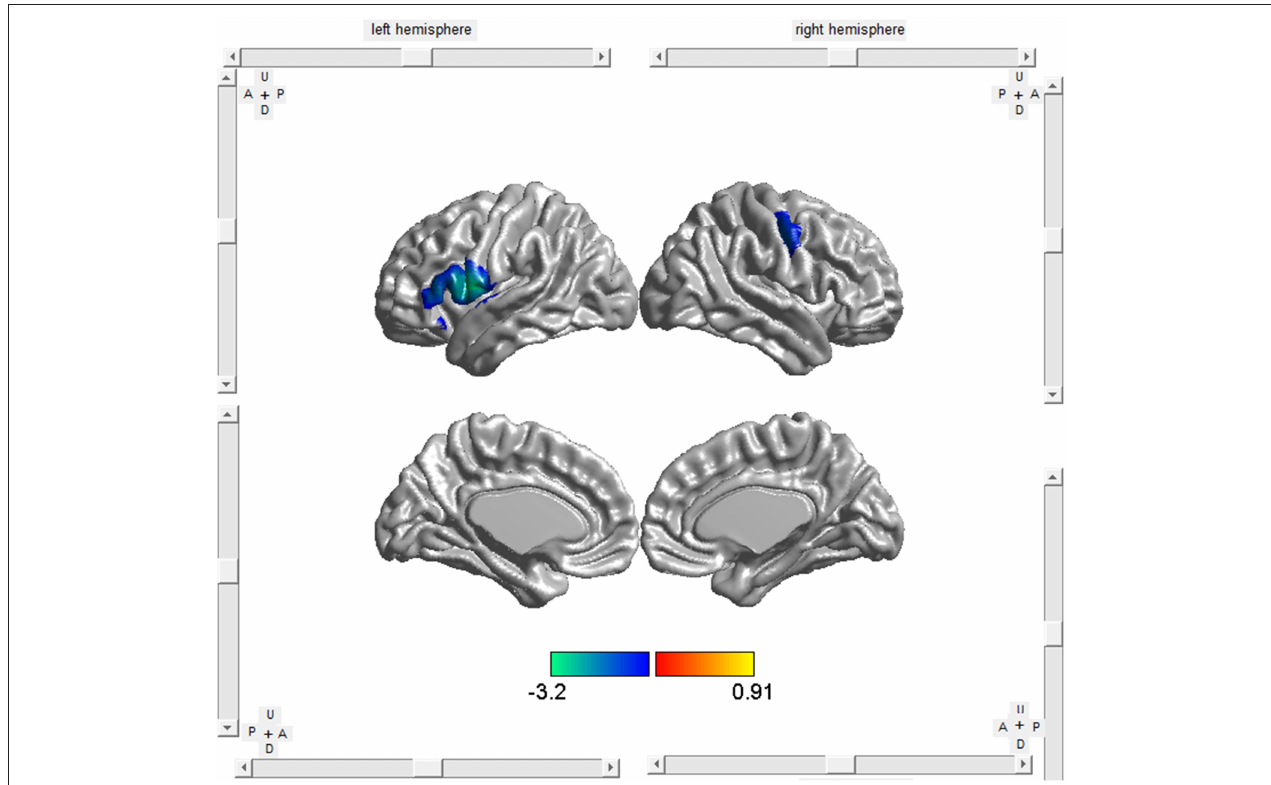
FIGURE 4 | Meta-regression analysis revealed that longer disease duration was associated with more GM atrophy in the left frontal aslant tract and the right precentral gyrus (BA 4) in ALS